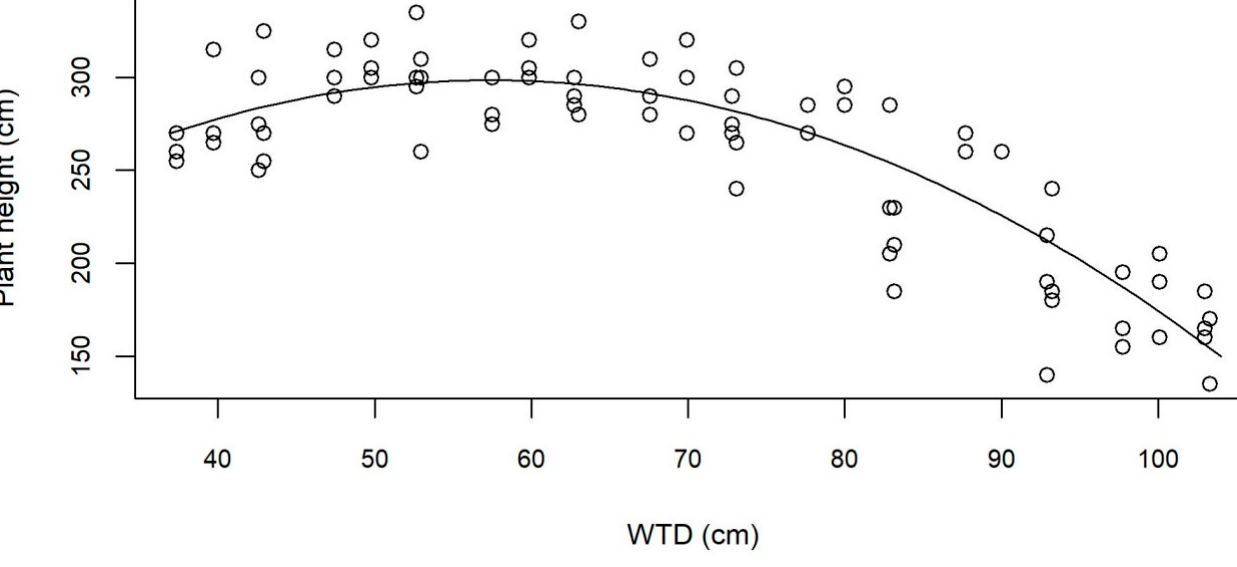
Figure 5. Plant height of cup plant at the end of the second growing season (September 2019) depending on water table distance (WTD). Mixed effect LM: random effect = tank number, square function, n = 84.